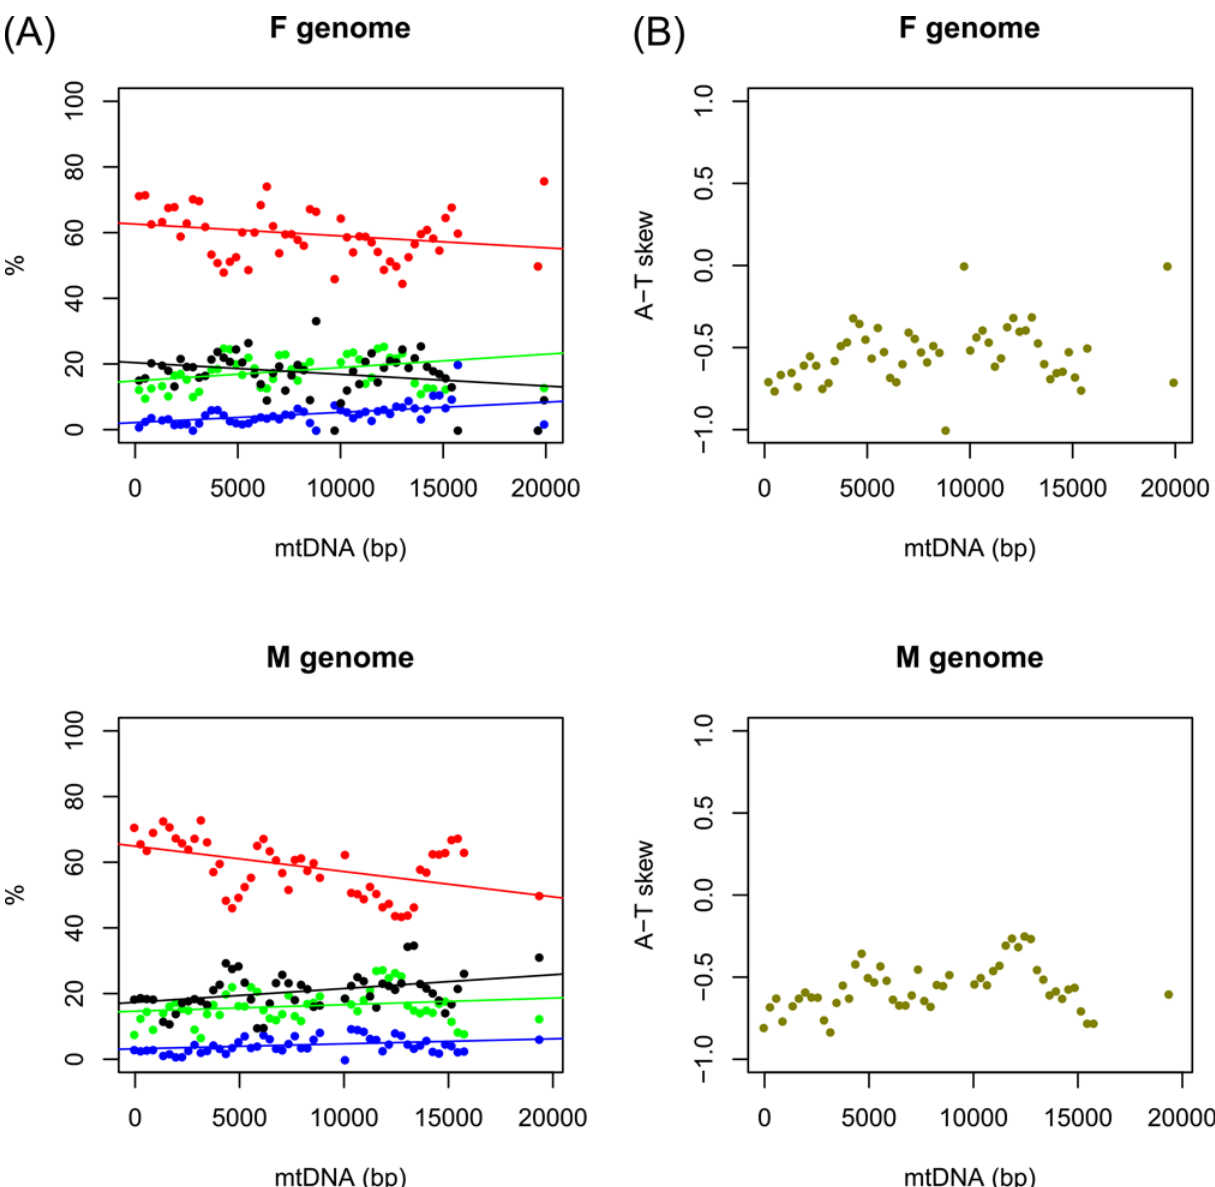
Fig 3. Origins of Replication. A, nucleotide composition at four-fold degenerate sites, using a sliding window of 700 bp with a step of 300 bp. The starting point is the first PCG after the LUR, i.e. cox3 . Equations are as follows, for F/M, respectively. A (green): y = 0 . 0004x+14 . 84 ; R 2 = 0 . 0681; p = 0 . 0616 / y = 0 . 0002x+14 . 62 ; R 2 = 0 . 0409; p = 0 . 1546 . C (blue): y = 0 . 0003x+2 . 15 ; R 2 = 0 . 2263; p = 0 . 0004 *** / y = 0 . 0002x+3 . 17 ; R 2 = 0 . 1087; p = 0 . 0181 * . G (black): y = − 0 . 0004x+20 . 39 ; R 2 = 0 . 0796; p = 0 . 0428 * / y = 0 . 0004x+17 . 33 ; R 2 = 0 . 1448; p = 0 . 0059 ** . T (red): y = − 0 . 0004x+62 . 61 ; R 2 = 0 . 0595; p = 0 . 0815 / y = − 0 . 0008x+64 . 88 ; R 2 = 0 . 2123; p = 0 . 0007 *** . B, A-T skew at four-fold degenerate sites, using a sliding window as for (A); the starting point is again cox3